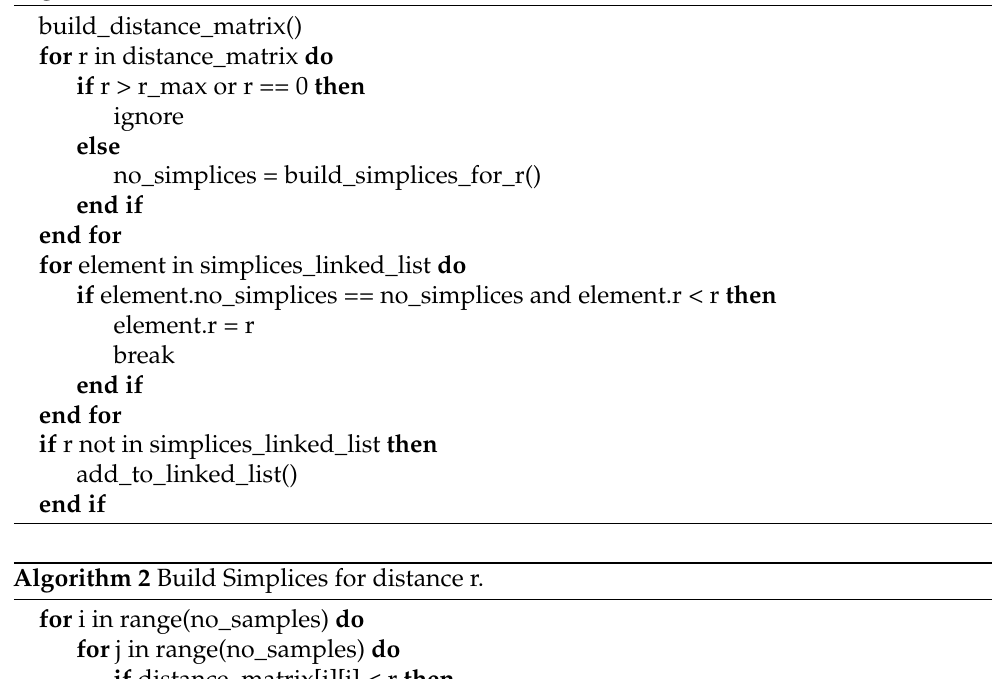
Algorithm 1 Build BarCode.